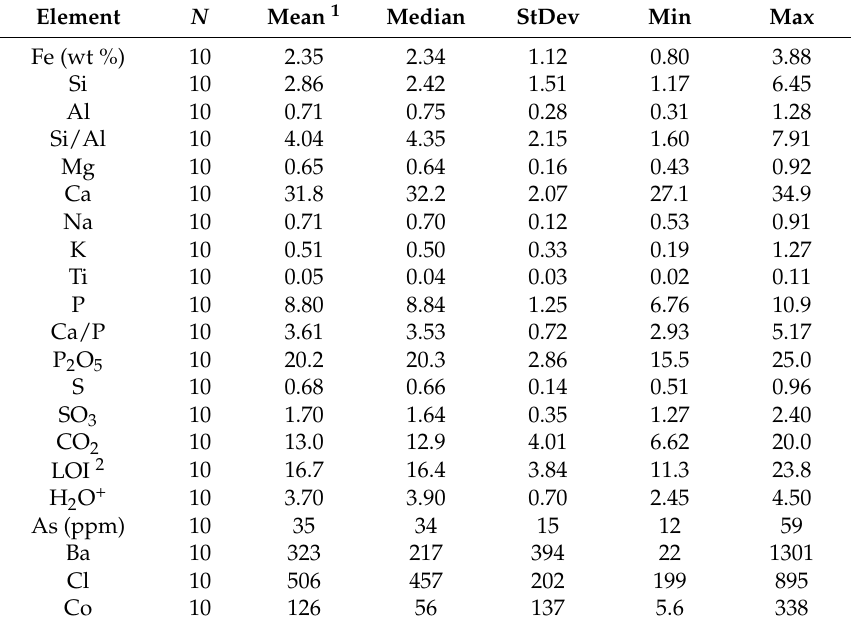
Table 6. Statistics of phosphorite deposits from Blake